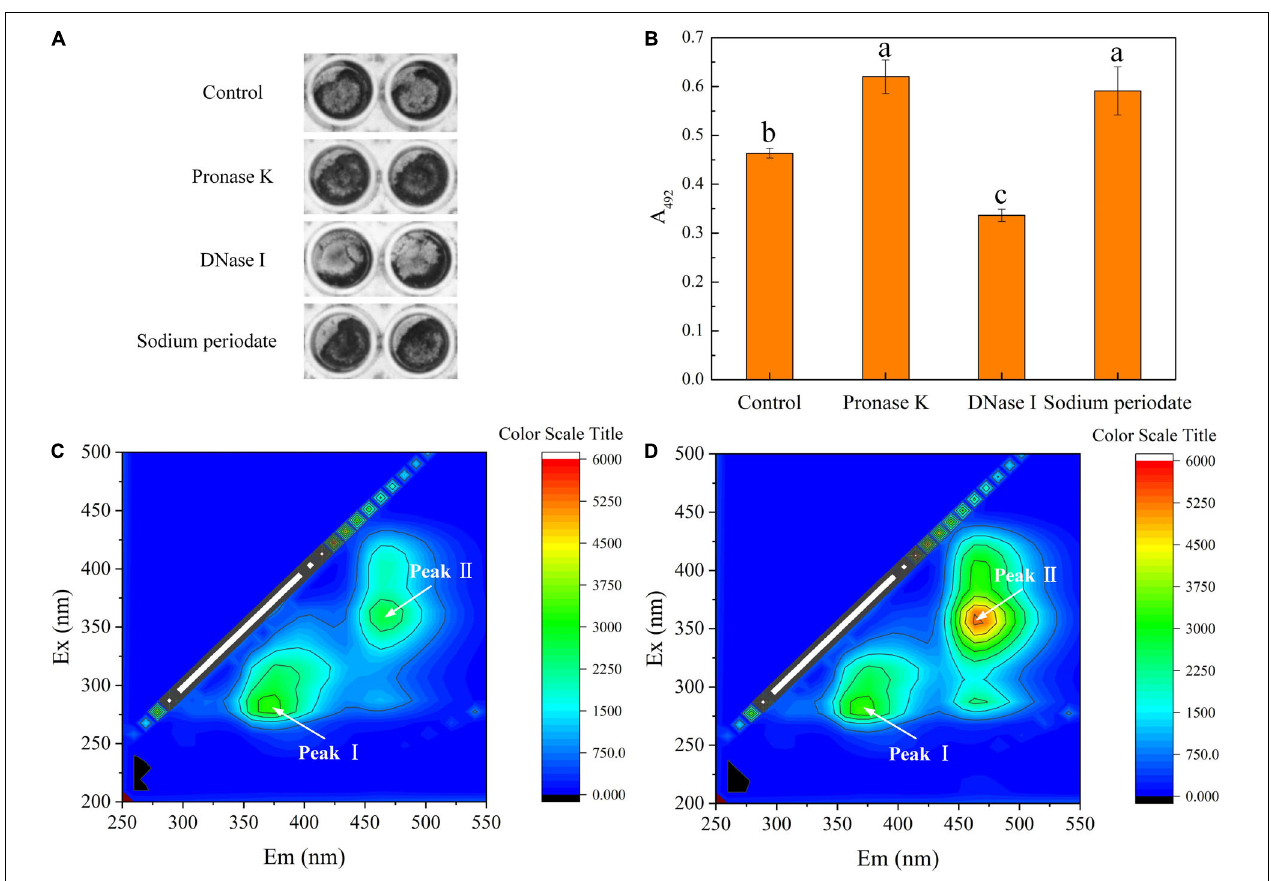
FIGURE 4 | Composition of biofilm matrix. (A) Crystal violet staining of biofilms untreated or treated for 24 h with proteinase K, DNase I, and sodium metaperiodate. (B) Quantification of biofilms untreated or treated for 24 h with proteinase K, DNase I, and sodium metaperiodate. (C) EEM fluorescence spectra of the matrix from planktonic cells. (D) EEM fluorescence spectra of the biofilm matrix. Significantly different ( p < 0.05) values are marked with different lowercase letters. The T. halophilus cells were incubated in 96-well plates for 48 h and then treated with proteinase K, DNase I, and sodium metaperiodate for 24